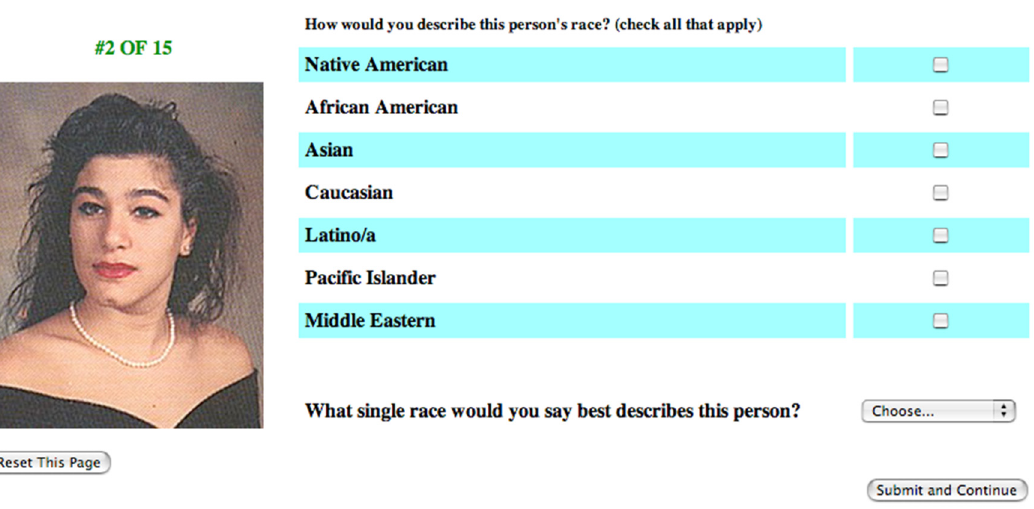
Figure 1. Racial identification of (N = 509) participants and all U.S. doctors.